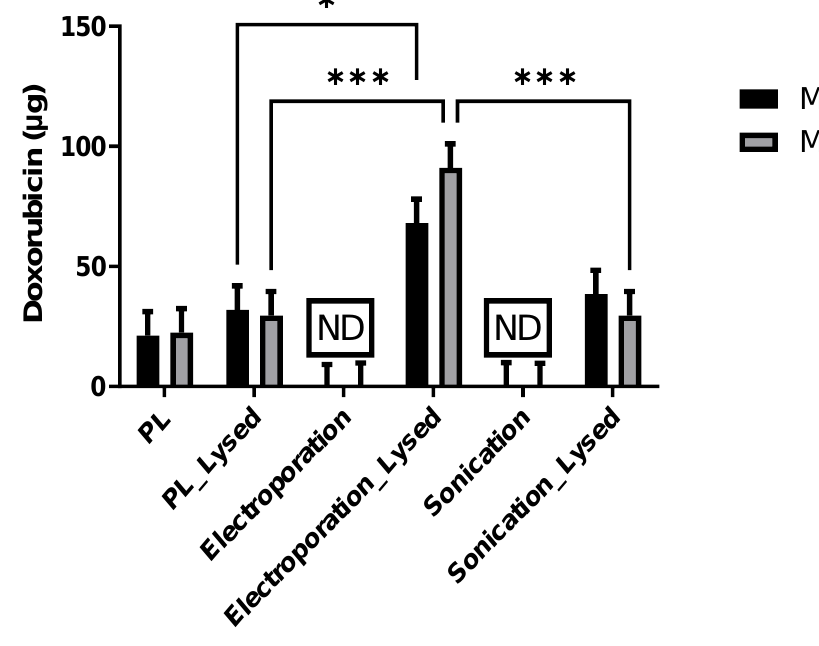
Figure 4. Dox quantities detected for non-lysed compared to lysed passive loaded (PL), electroporation loaded, and sonicated loaded MSC EVs and milk EVs. Results are mean from n > 3 ± SEM biological repeat experiments. Statistical analysis was done through 2-way Anova. * represents p value < 0.05, and *** p < 0.001. ND = not detected.